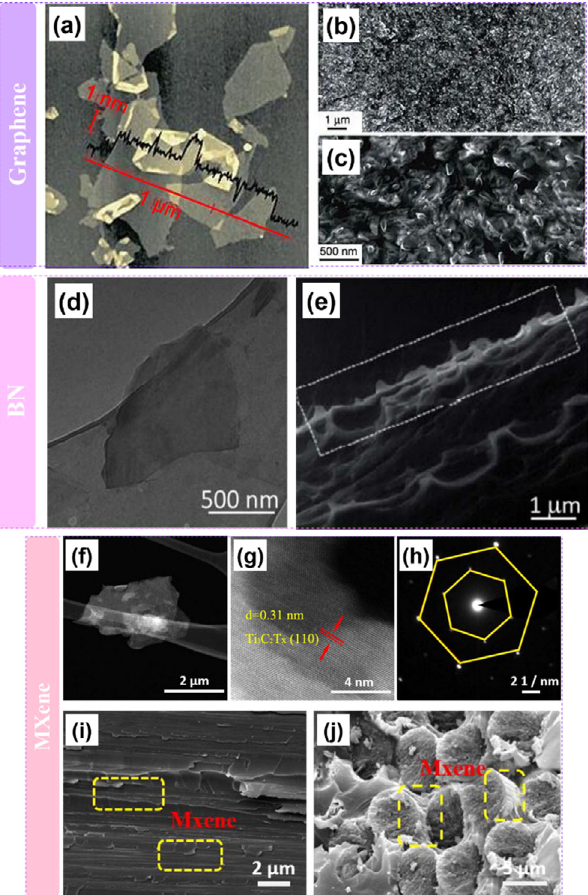
Fig. 6 Morphology images of (a) graphene and (b, c) its composite. Reproduced with permission from Ref. [1], © Springer Nature 2006. (d) BN and (e) its composite. Reproduced with permission from Ref. [83], © RSC 2009. (f–h) MXene and (i, j) its composite. Reproduced with permission from Ref. [101], © Springer Nature